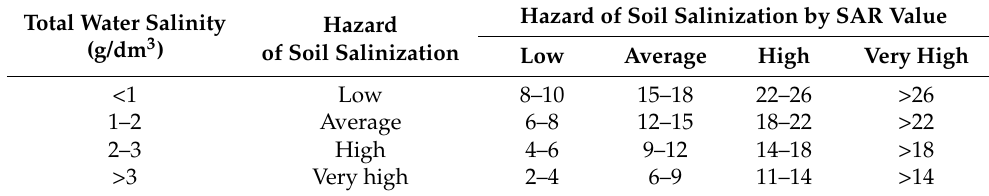
Table 2. Assessment of water quality by SAR